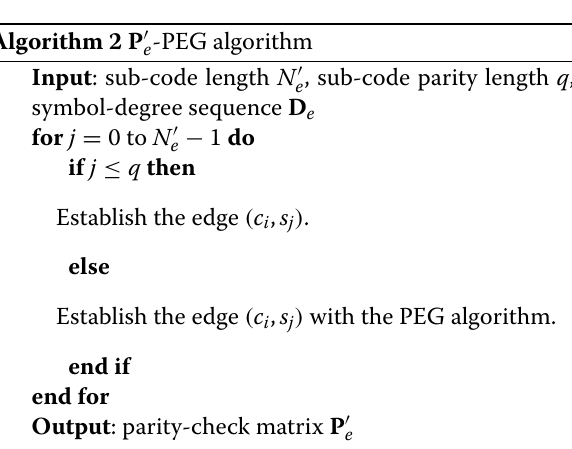
Algorithm 2 P (cid:4)